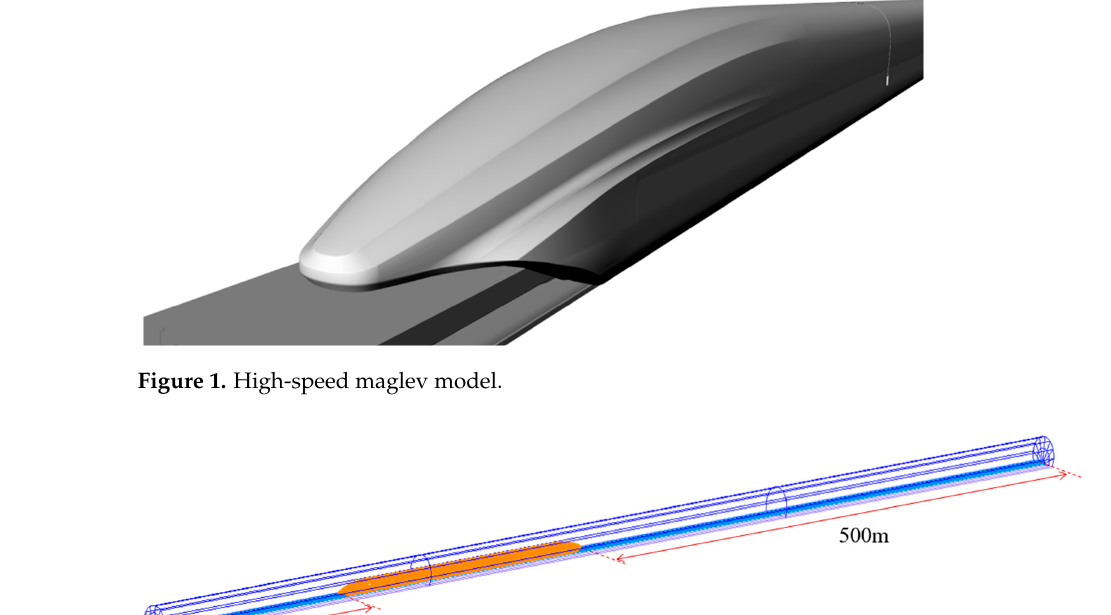
Figure 2. Computational model.